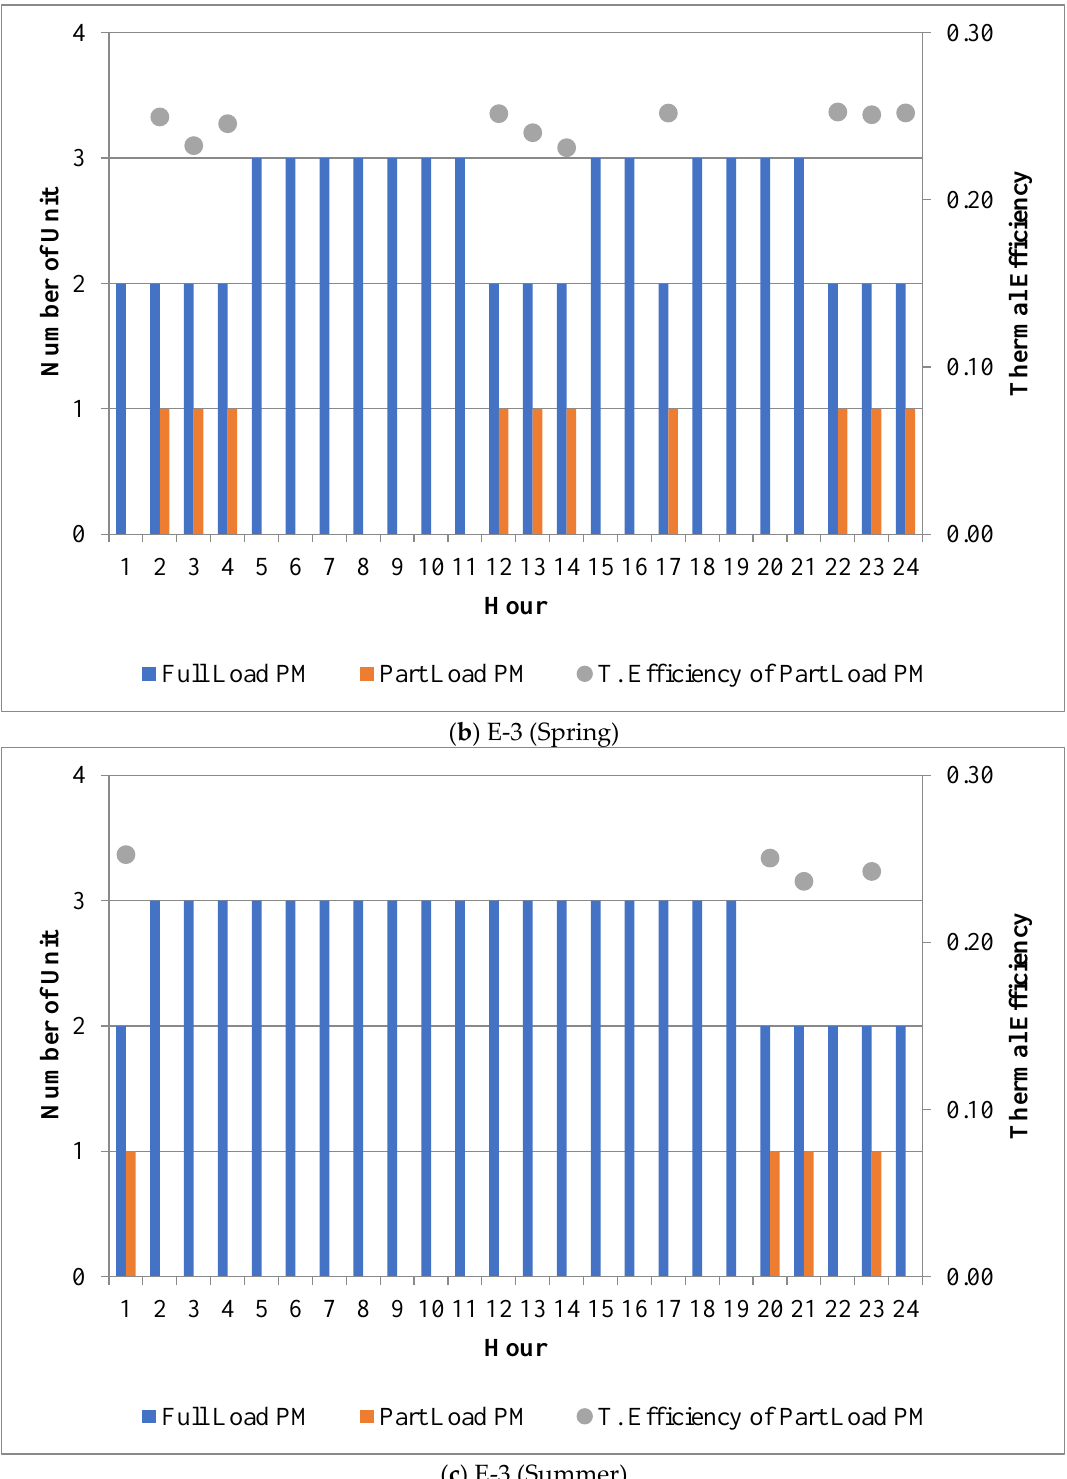
Figure 14. Hourly operating information for a specific day in different seasons in Case D.